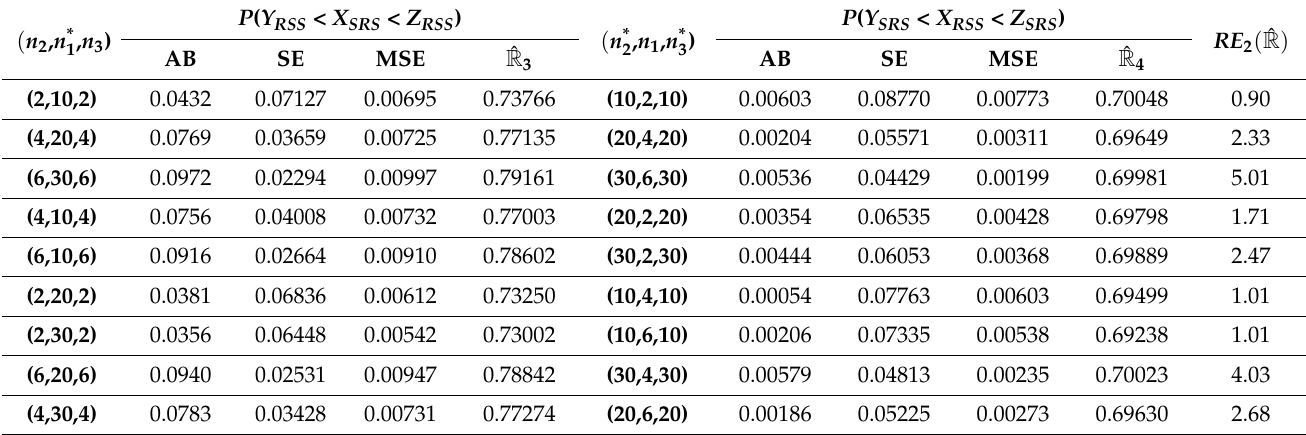
Table 8. Measurements of ˆ R 3 and ˆ R 4 for sampling schemes at R = 0.694 and d =